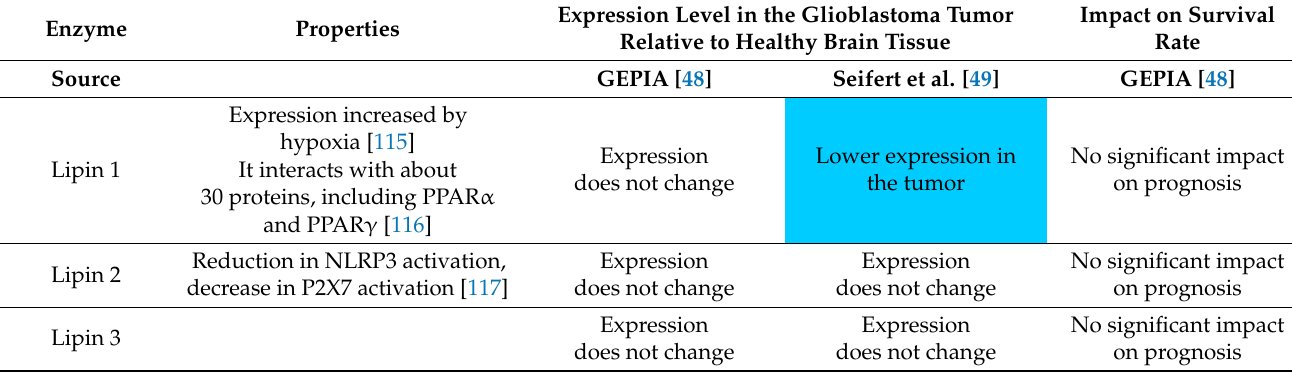
Table 6. Characteristics of lipins, enzymes involved in DAG biosynthesis from phosphatidic